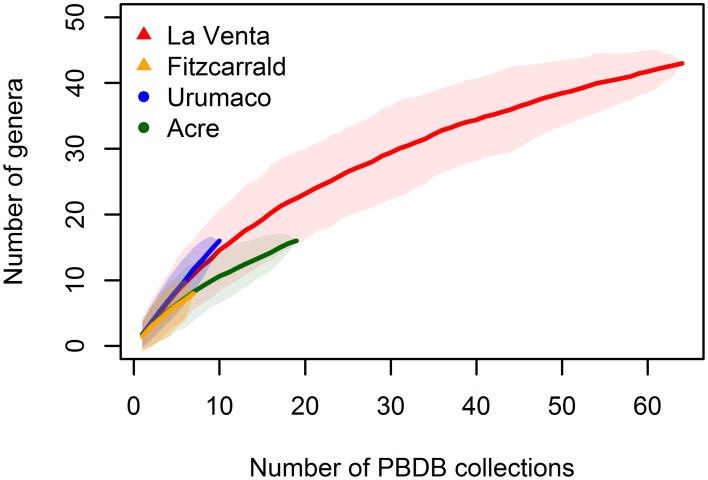
Accumulation curves estimated with random method for the tropical faunal associations, shaded areas represent the 95% confidence interval.